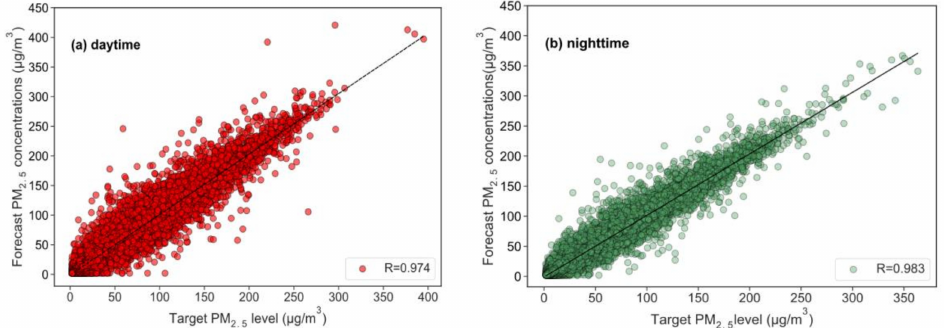
Figure 4. Scatter plots of forecasted and target fine particulate matter (PM 2.5 ) concentrations based on the OR-ELM-AR during the daytime ( a ) and during the nighttime ( b